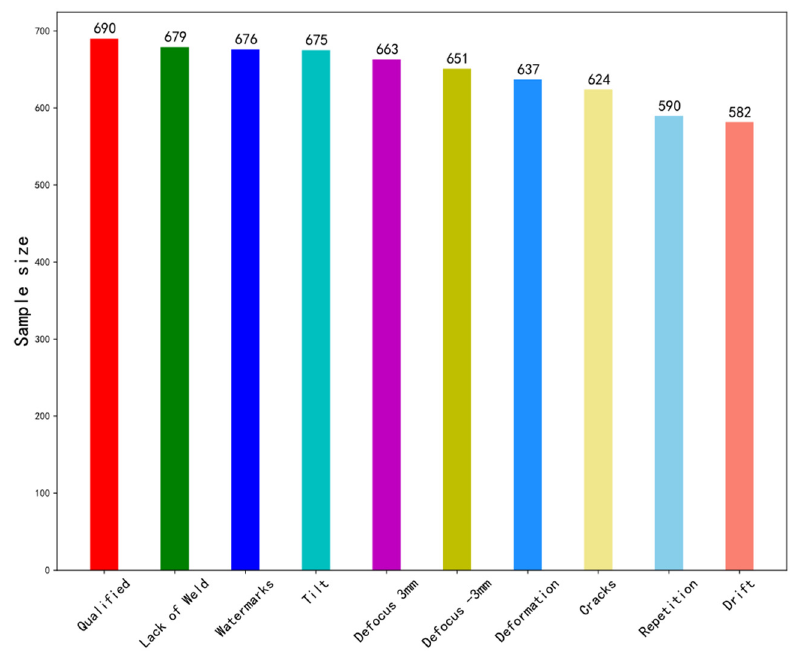
Figure 3. The composition of the data set.